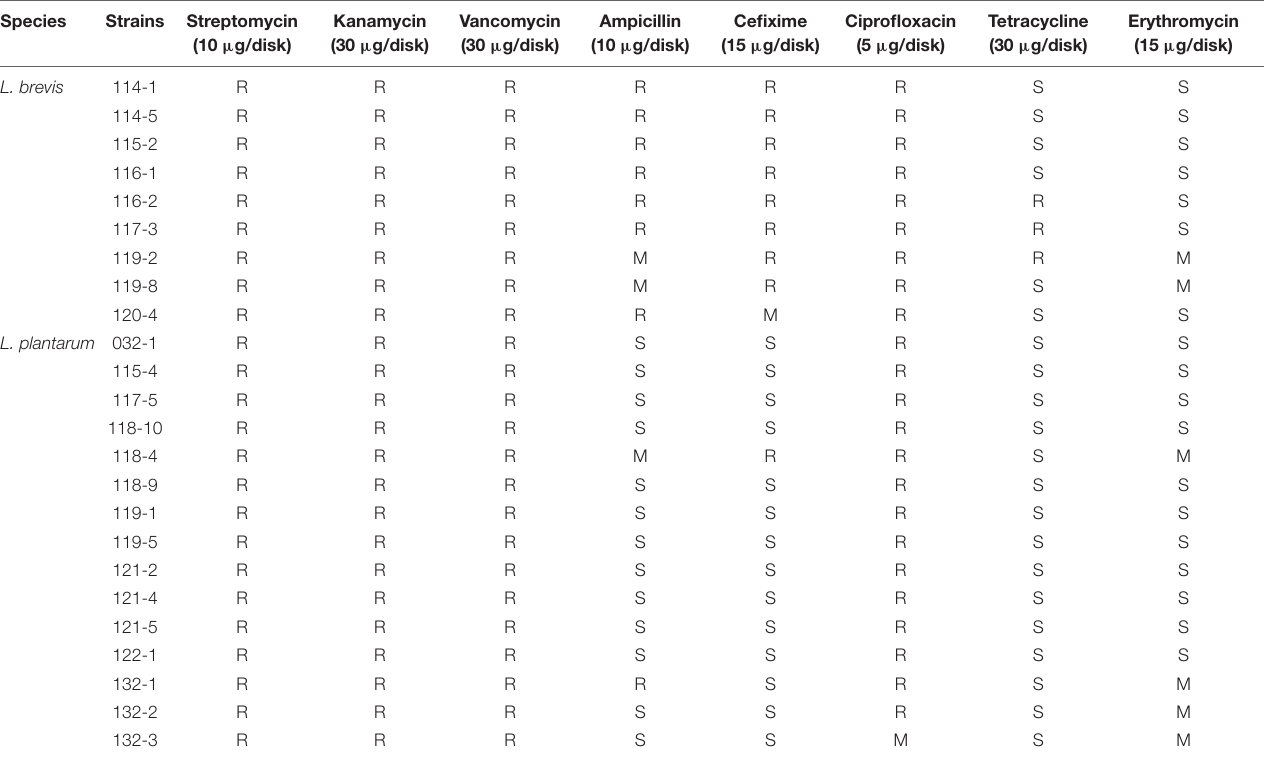
TABLE 4 | Antibiotic susceptibility of Lactobacillus strains from fermented vegetables in Shaanxi, China. Species Strains Streptomycin (10 µ